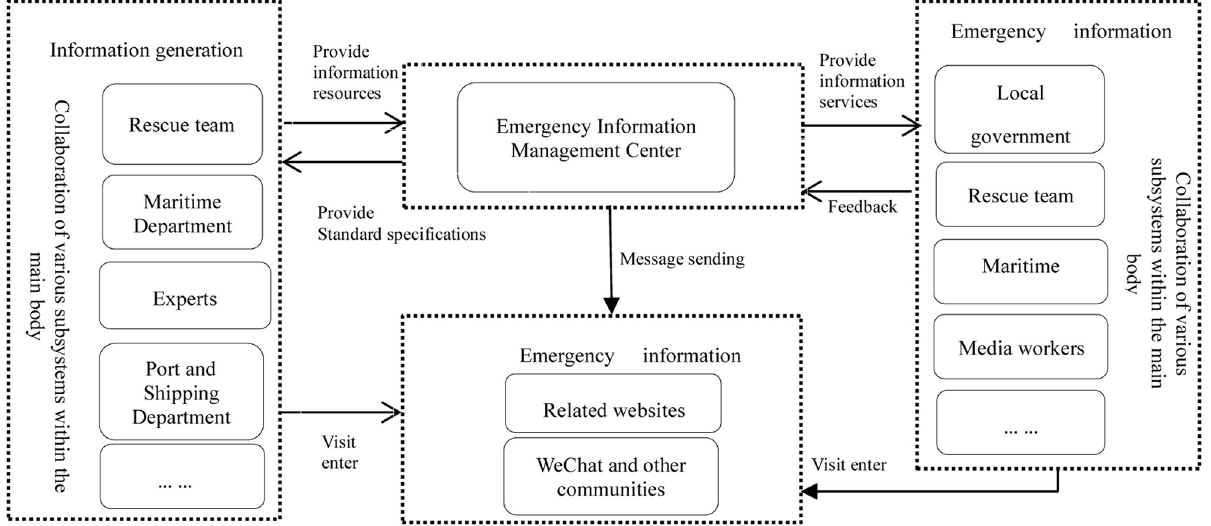
Fig 2. Coastal city disaster prevention and mitigation emergency information sharing framework based on collaboration theory.